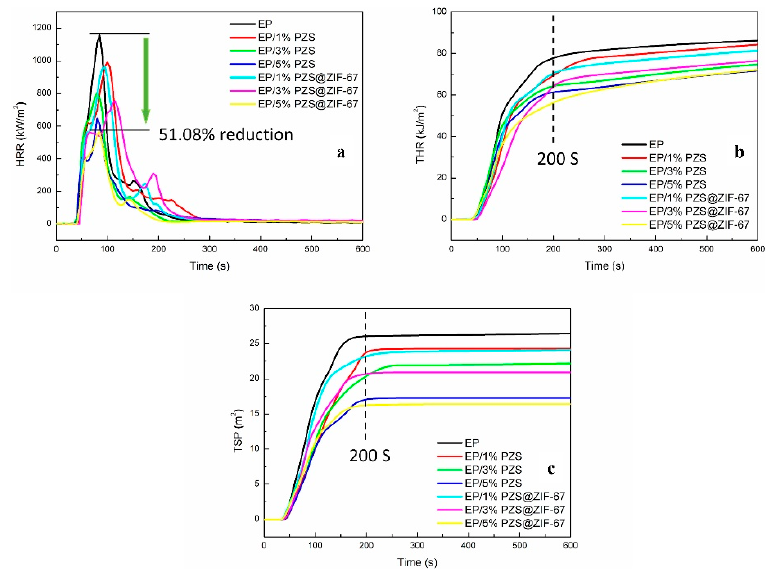
Figure 7. HRR ( a ), THR ( b ), and TSP ( c ) vs. time curves of pristine EP and its composites.